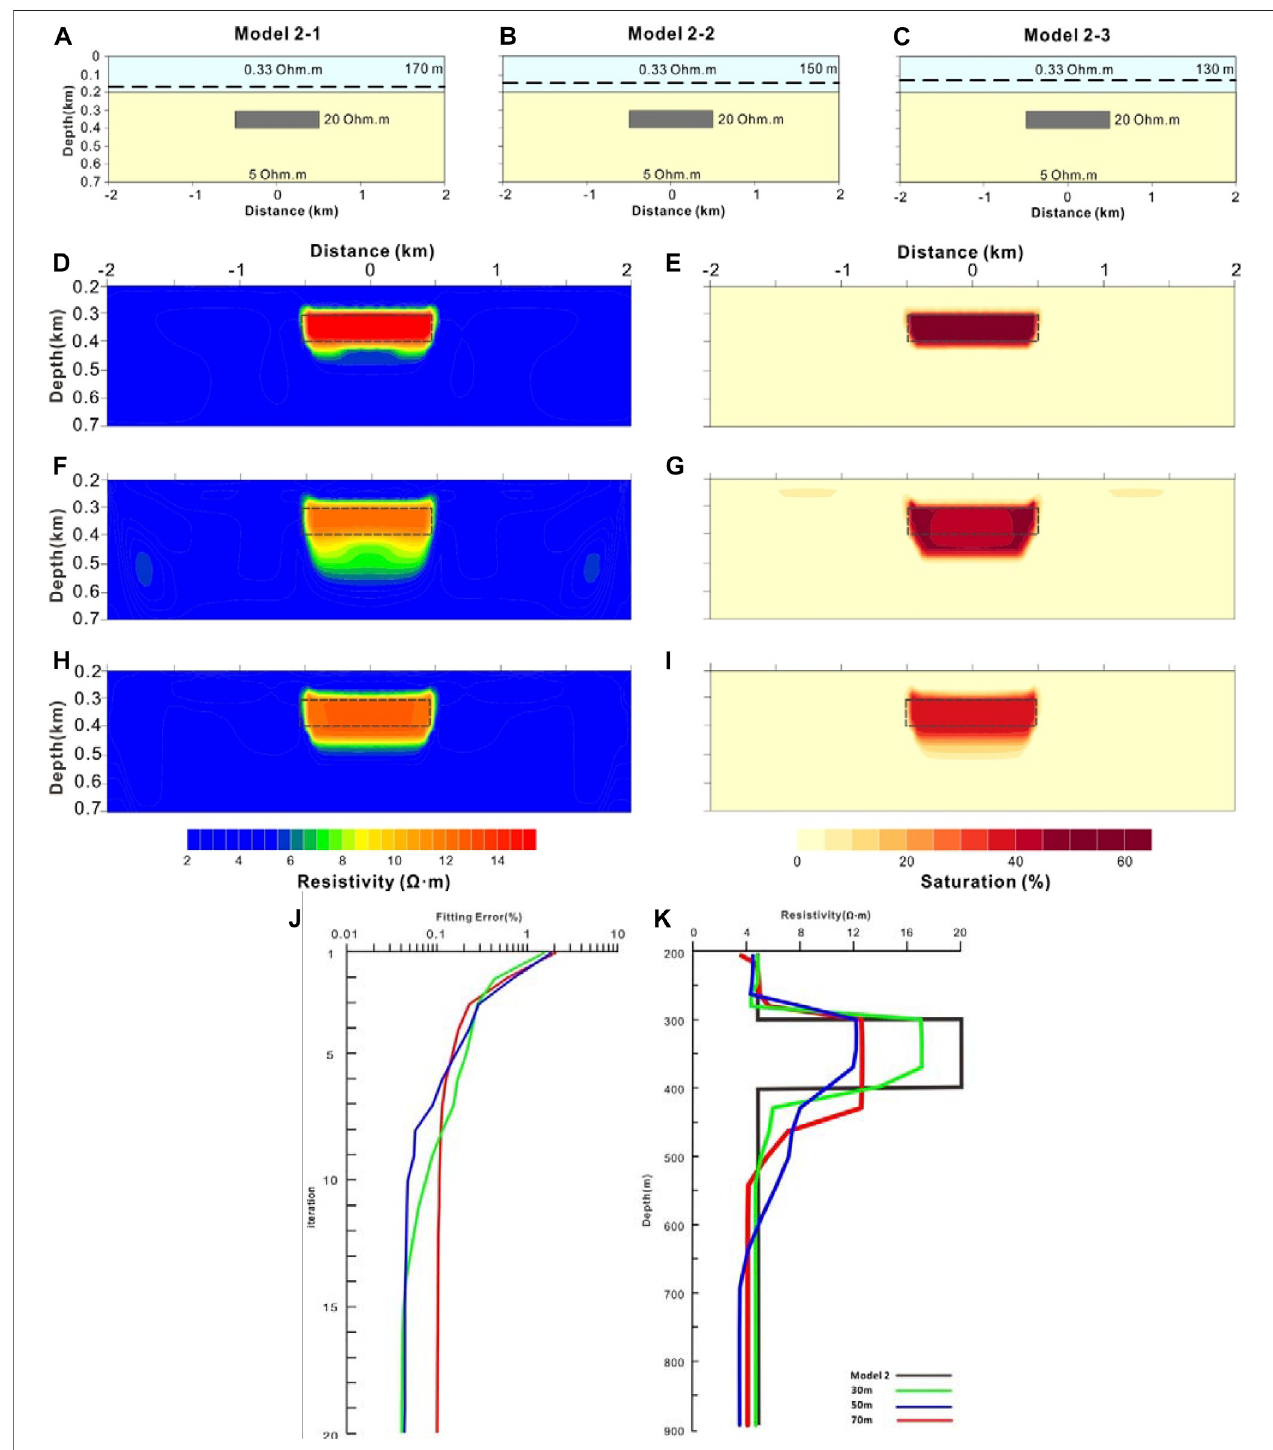
FIGURE 5 | Resistivity inversion and hydrate saturation estimation of variable towed height model of the array arrangement away from the sea fl oor. (A) – (C) : In the schematic diagram of Model 2 – 1, 2-2, and 2-3 respectively, light blue indicates seawater, light yellow indicates marine sediments, gray block indicates hydrate reservoirs, dotted line indicates the track of the towed DCR array arrangement; (D) , (F) and (H) : the inversion resistivity of Model 2 – 1, 2-2, and 2-3 respectively; (E) , (G) and (I) : the hydrate saturation estimation of Model 2 – 1, 2-2, and 2-3 respectively (J) : the inversion iteration convergence of Model 2 – 1(green), 2 – 2(blue) and 2 – 3 (red), respectively (K) : the resistivity pro fi le with depth at the center x position of hydrate reservoir of Model 2 – 1(green), 2 – 2(blue) and 2 – 3 (red), respectively.